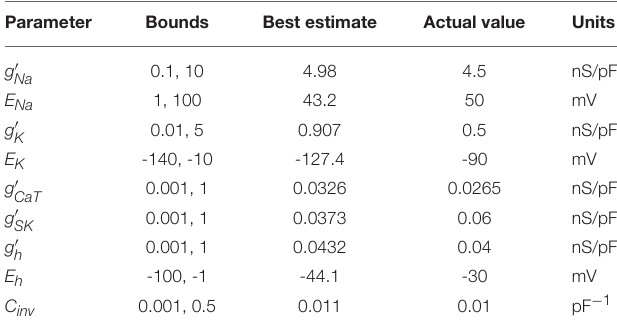
The best prediction is chosen by finding the highest correlation coefficient between the predictedvoltageand“real”voltage.Thiscomparisoncanbemadeonexperimentaldata. It represents an attractive alternative to the familiar least squares metric commonly used. That metric is very sensitive to spike times in data with action potentials: small errors in spike times may result in large errors in a least squares